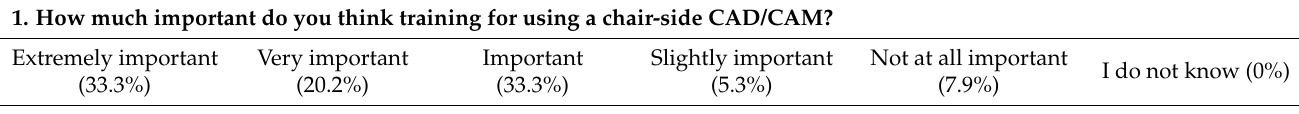
Table 4. Response of participating dentists to training-related questions (No. =